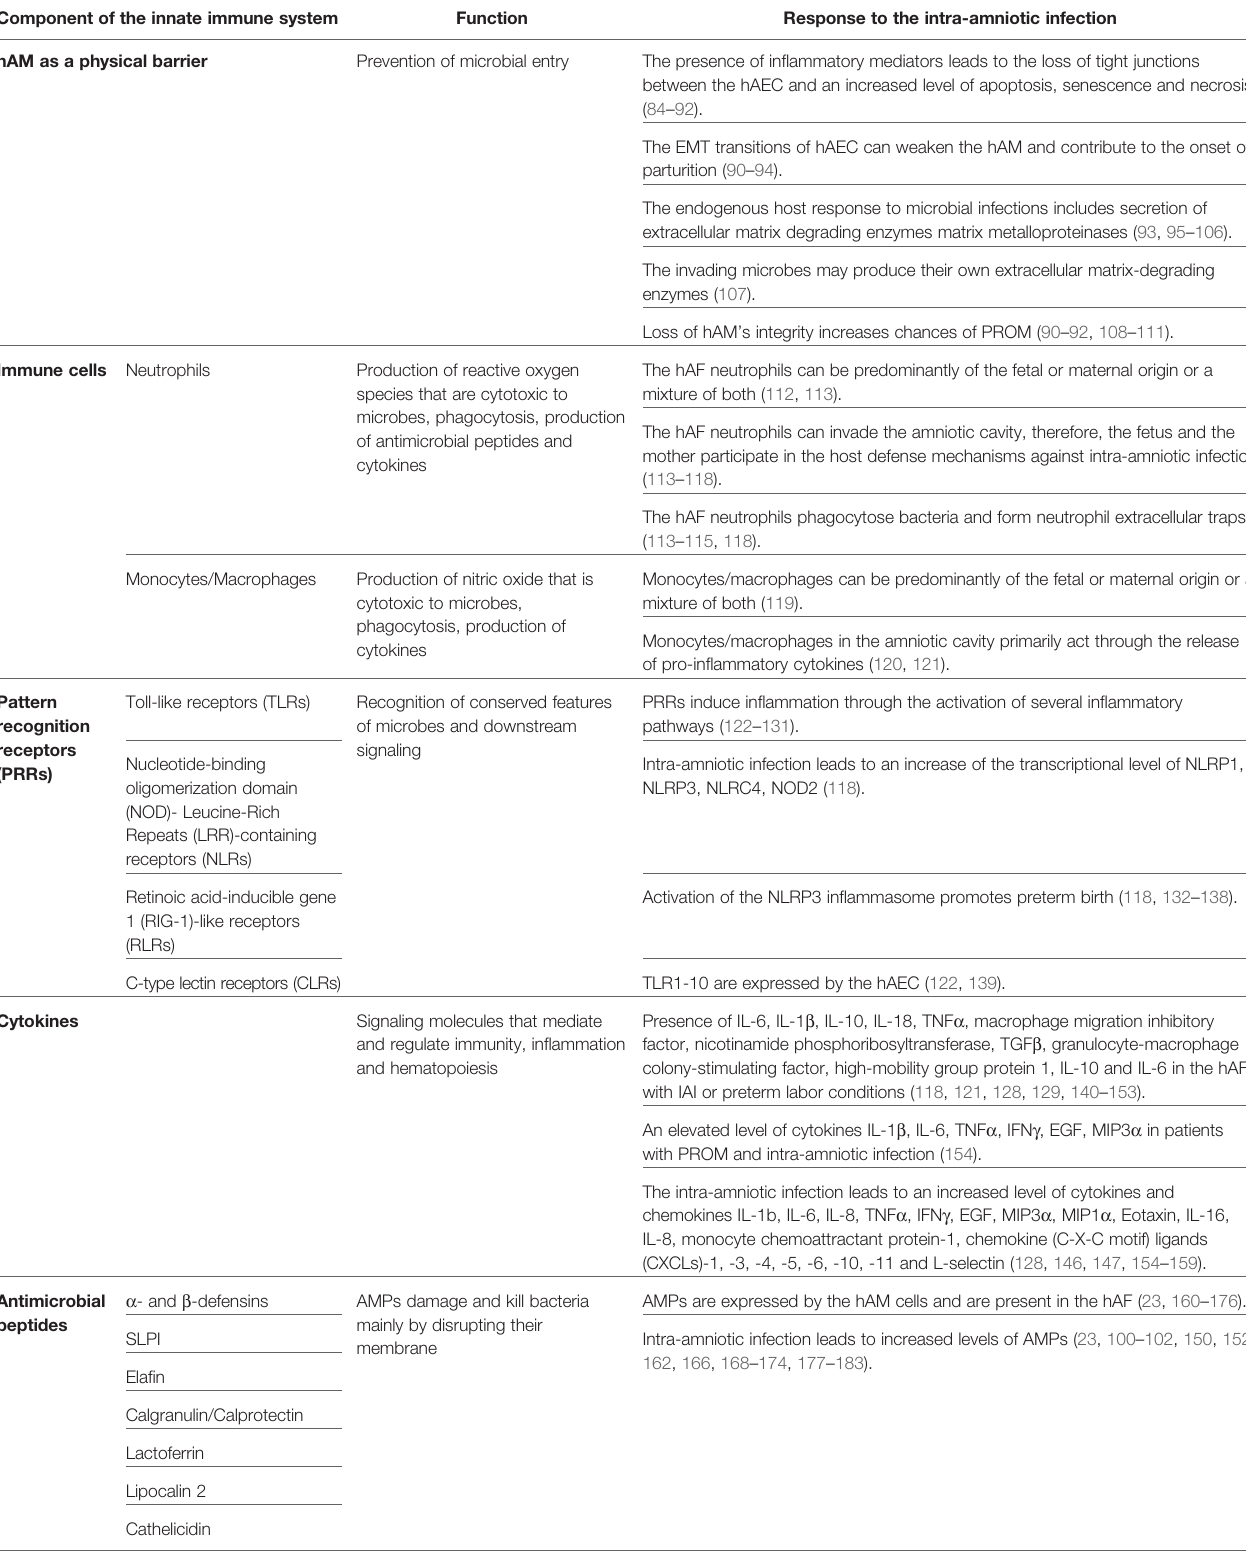
TABLE 1 | Response of various components of the innate immune system to the intra-amniotic infection/in fl ammation. Component of the innate immune